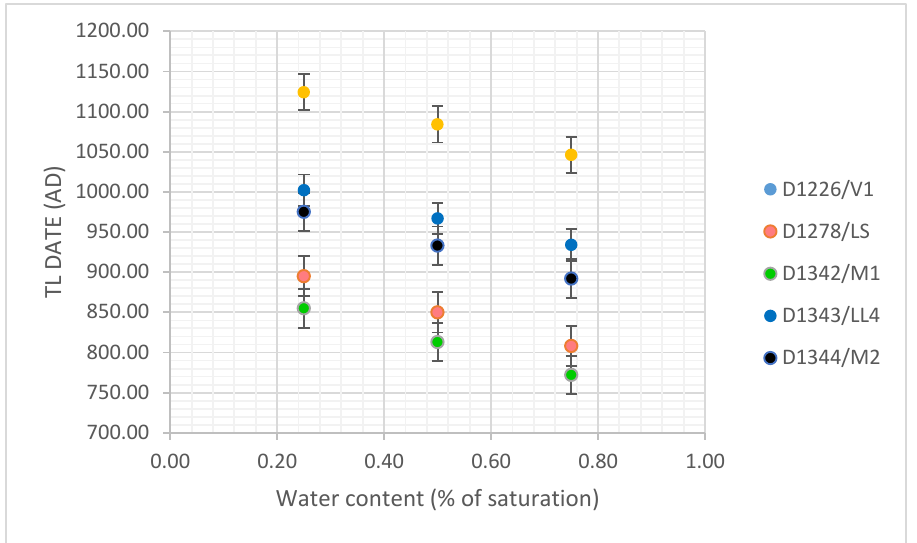
Figure 3. Possible dates for casting (water content, 25 – 75% of saturation; effective external dose rate, 1.5 ± 0.5 mGy/a).